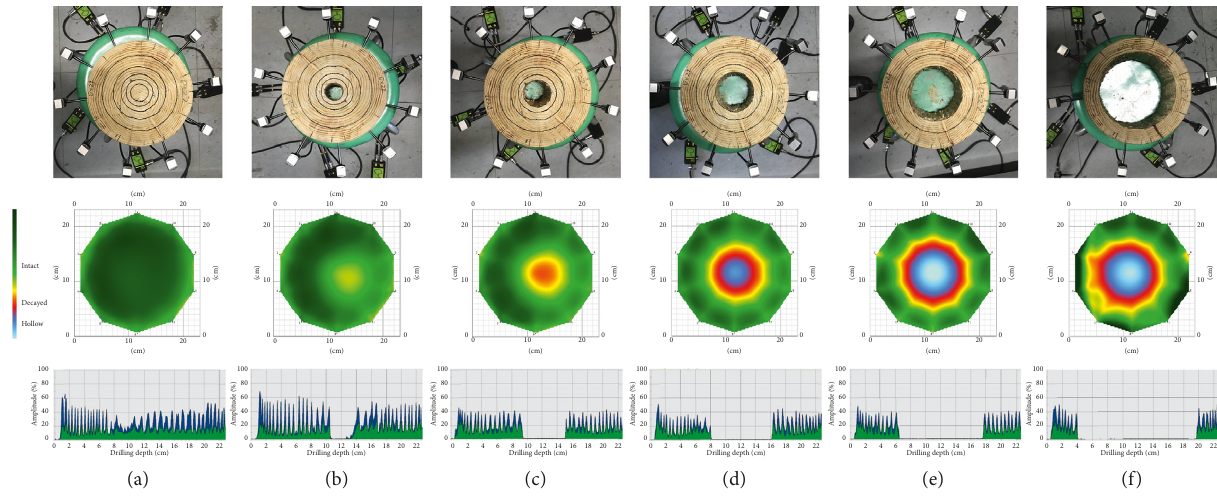
Figure 7: Detection of two-dimensional images of specimen 2: (a) 0; (b) 1/32; (c) 1/16; (d) 1/8; (e) 1/4; (f) 1/2. Table 2: Results of two detection